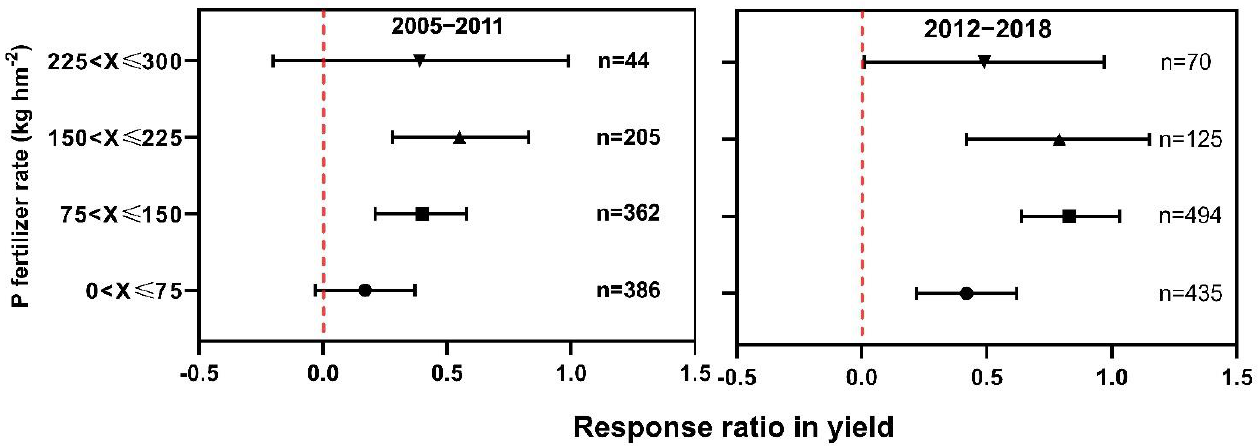
Figure 8. The effects of P fertilization levels on maize yield in different periods. The error lines indicate the 95th percentile bootstrap confidence intervals, whereas n values indicate the corresponding number of observations (total number of control and treatment values). Yield with P fertilization is a treatment value, whereas yield without P fertilization is a control value.